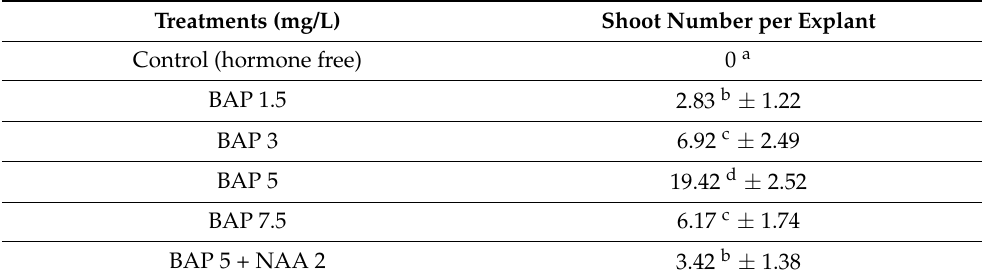
Table 1. Effect of different hormone combinations in MS media for shoot proliferation.